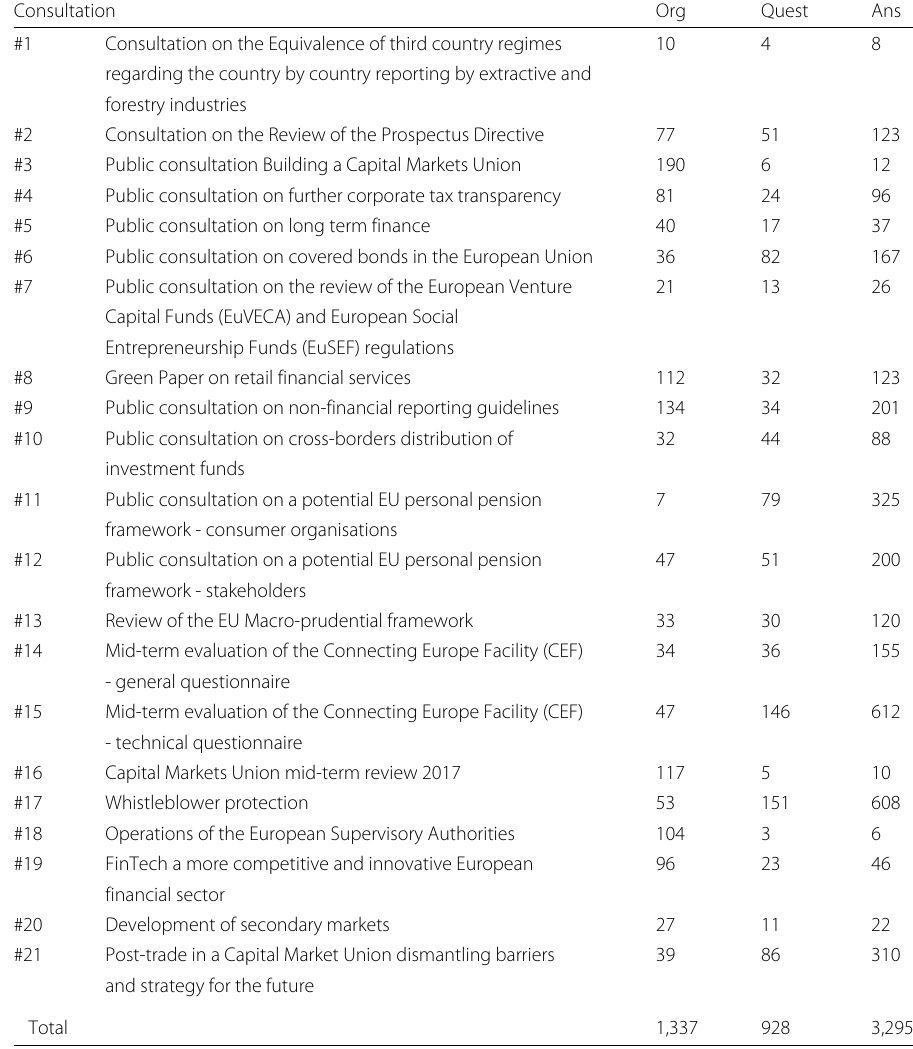
Table 2 Public consultations analyzed in this study and the number of lobby organizations (Org) which responded to